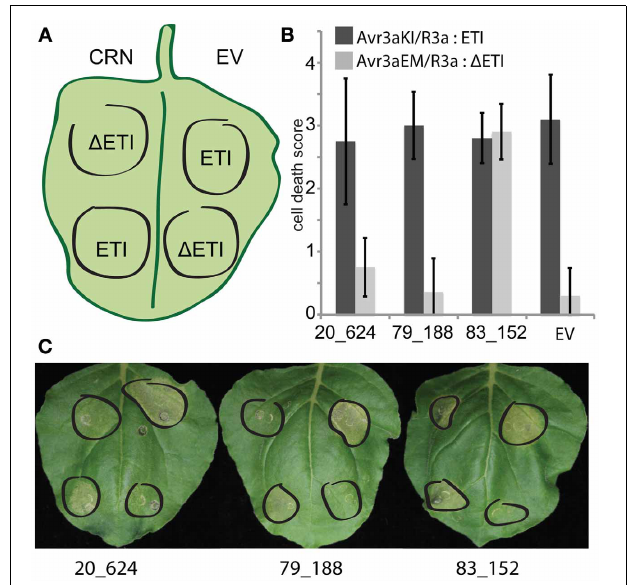
FIGURE 4 | Necrosis inducing CRNs do not cause altered ETI responses within the plant. (A) Graphical representation of the experimental set-up. CRN-GFP fusion and EV constructs were co-infiltrated into N. benthamiana leaves with Avr3a KI and R3a (ETI), and Avr3a EM and R3a ( (cid:2) ETI) to monitor ETI responses. After 48h, leaves were infiltrated with dexamethasone and incubated for a further 24h for induction of Avr3a expression. (B) Cell death in response to CRNs in ETI and non-ETI induced leaves scored on a scale of 0–6. Graph shows average necrosis scores ± standard deviation for one representative experiment. (C) Examples of representative leaves for each treatment on day of